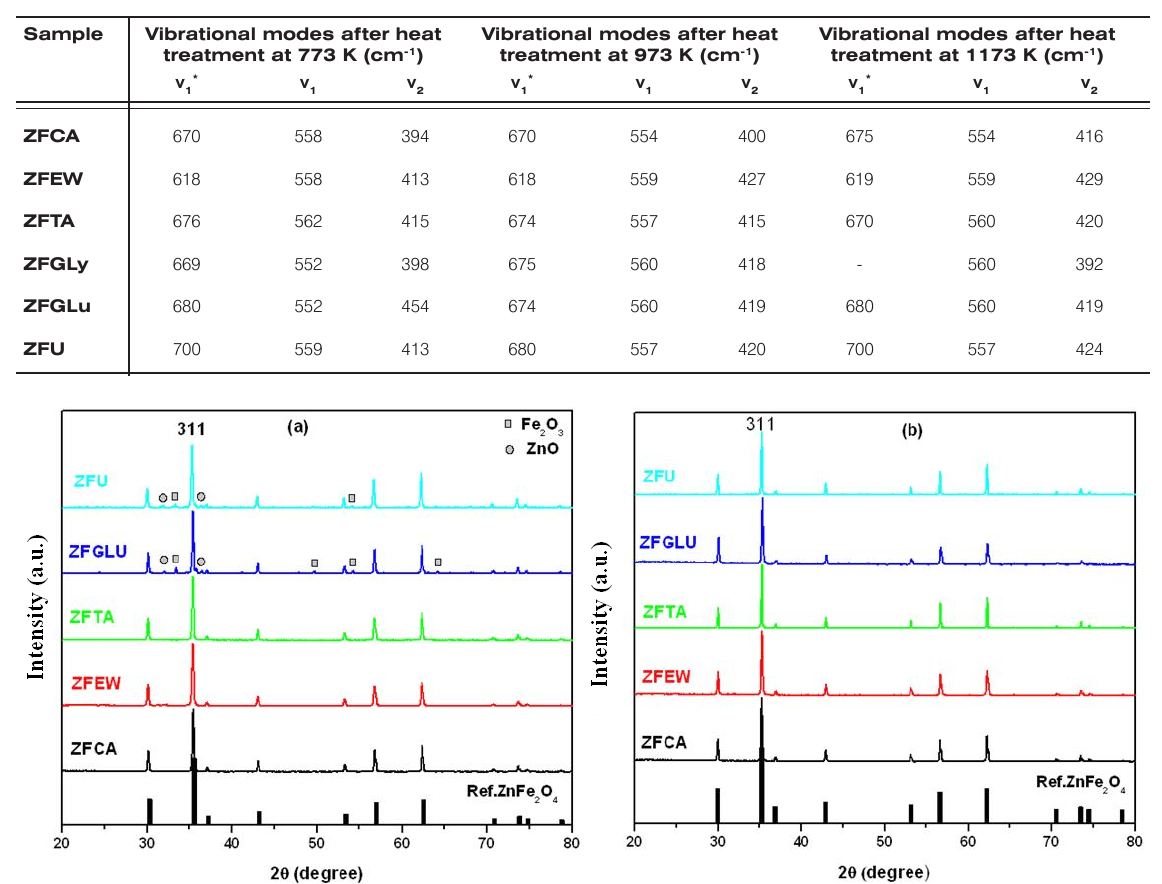
Figure 2. XRD patterns for ZF samples: (a) after heat treatment at 973 K (with Ref. ZnFe heat treatment at 1173 K (with Ref. ZnFe